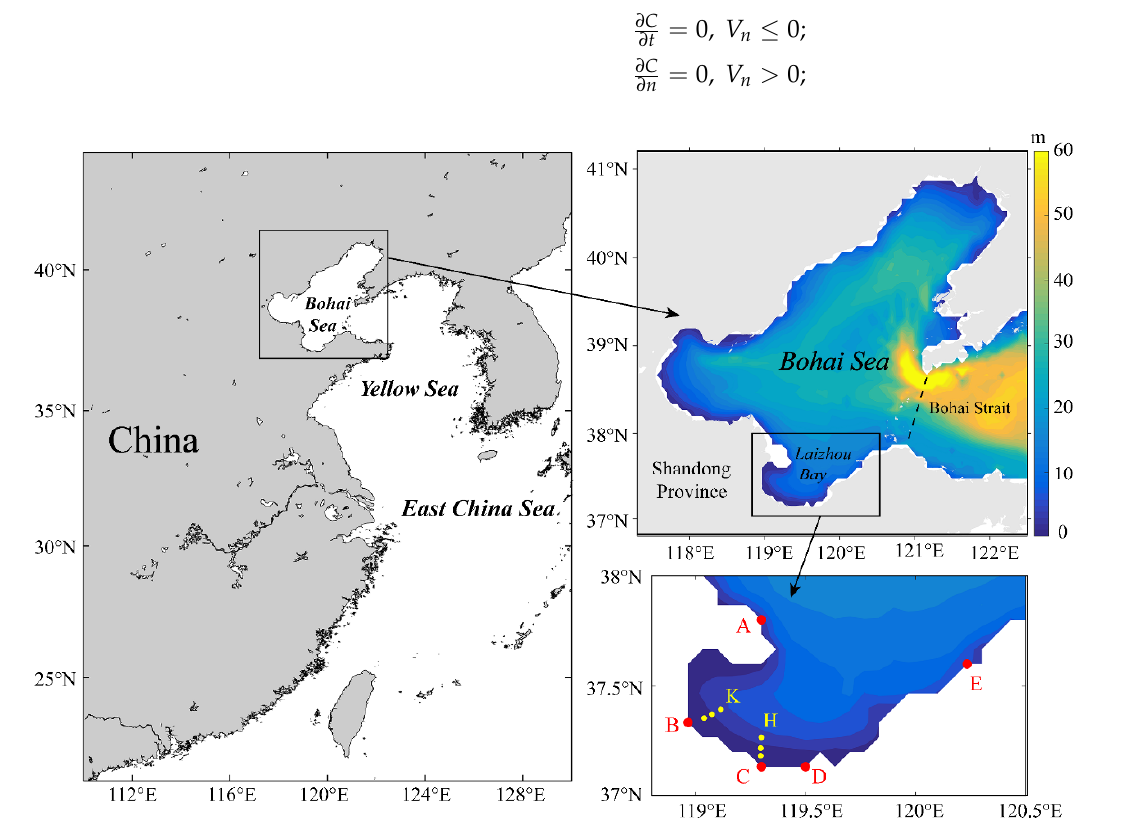
Figure 1. Map of Laizhou Bay showing 5 estuaries and sampling sites (A: Yellow River, B: Xiaoqinghe River, C: Yuhe River, D: Jiaolaihe River, E: Jiehe River; yellow dots represent K-section and H-section of sampling sites, respectively).